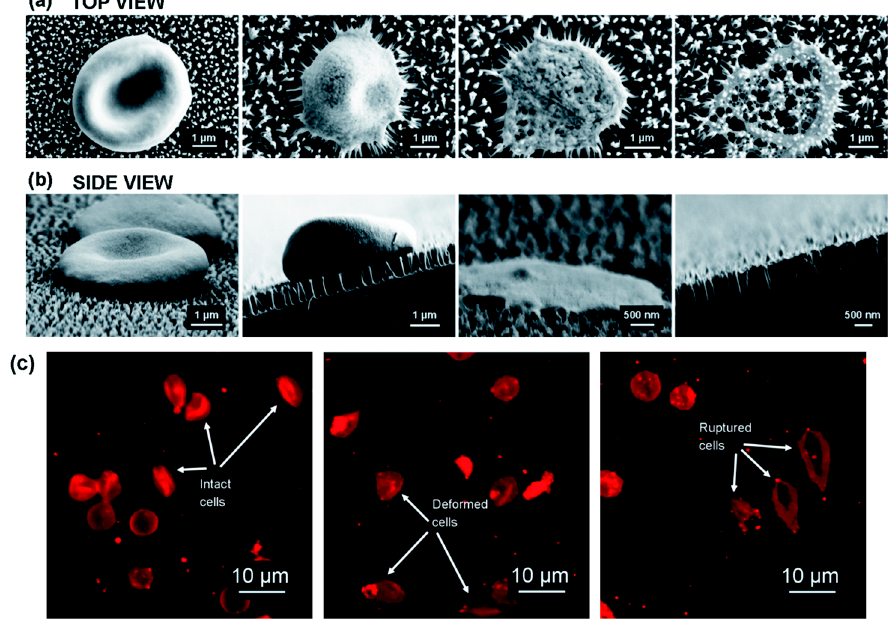
Figure 8. Cell lysis using nano pillars: ( a , b ) top and side view of the cells interacting with the nanopillars; and ( c ) confocal laser scanning microscopy pictures of intact, deformed and ruptured cells. Reproduced with permission from [51].